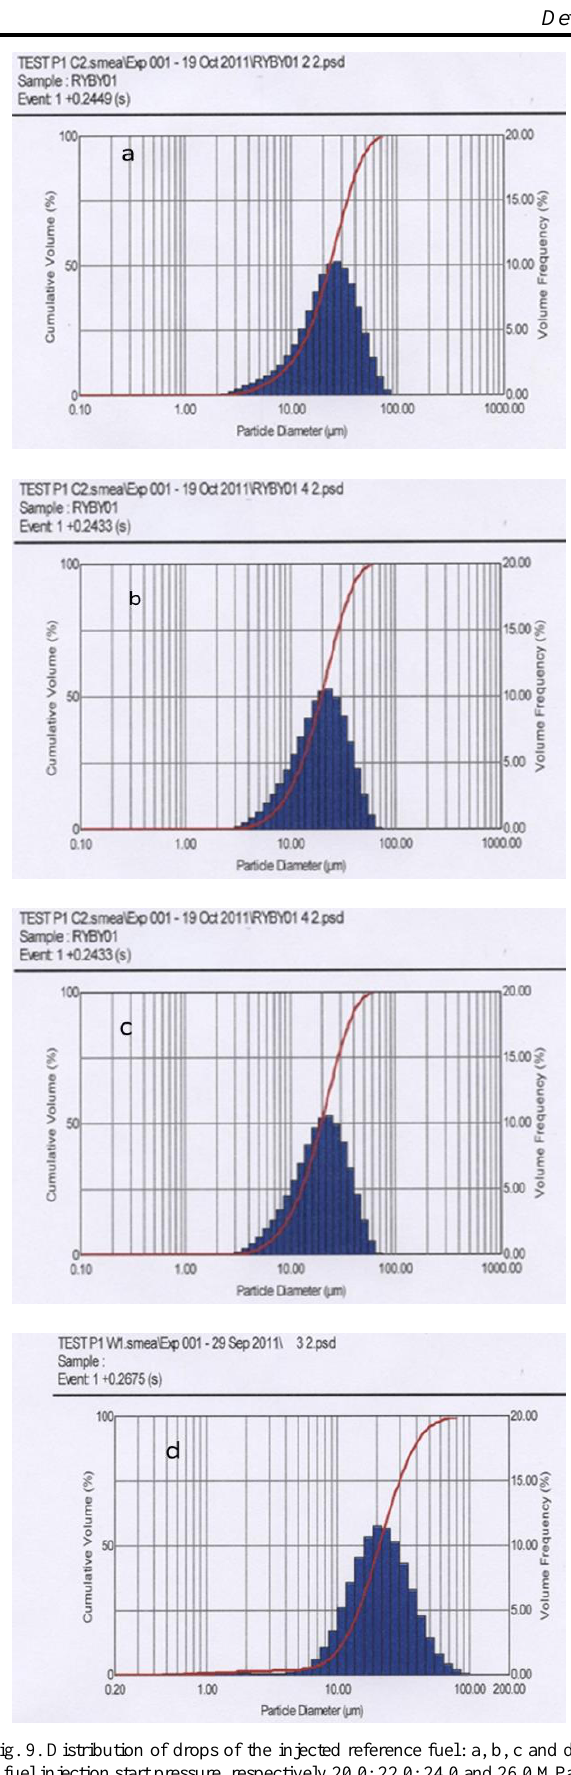
Fig. 9. Distribution of drops of the injected reference fuel: a, b, c and d – fuel injection start pressure, respectively 20.0; 22.0; 24.0 and 26.0 MPa